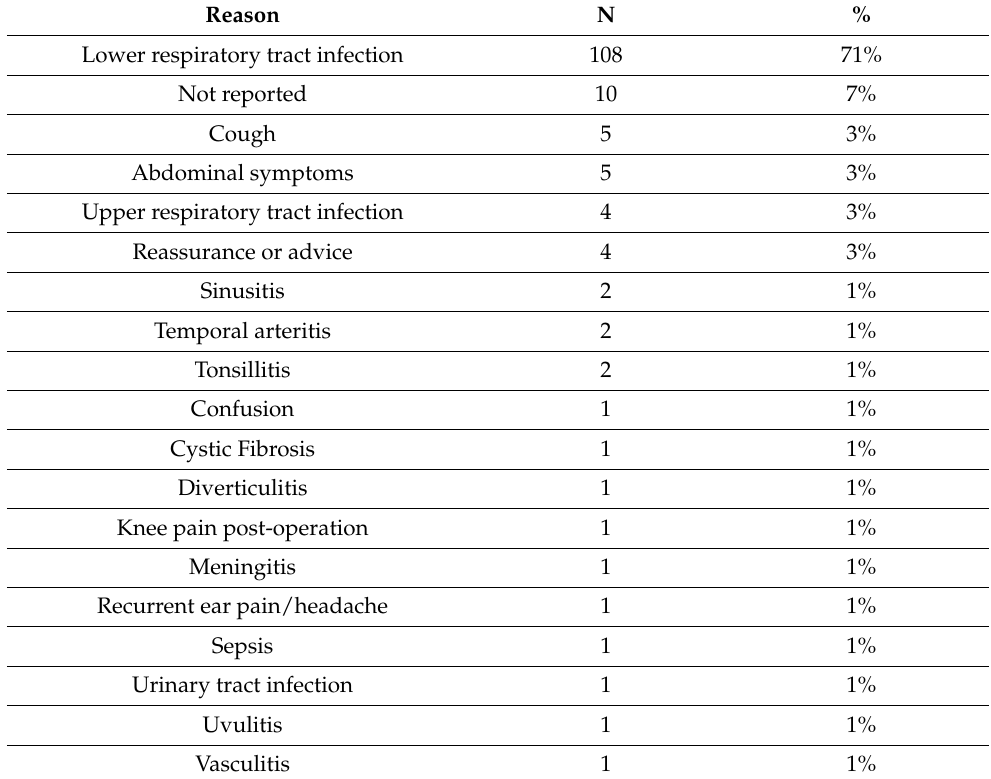
Table 1. Log sheet of the recorded reasons for doing a POC CRP